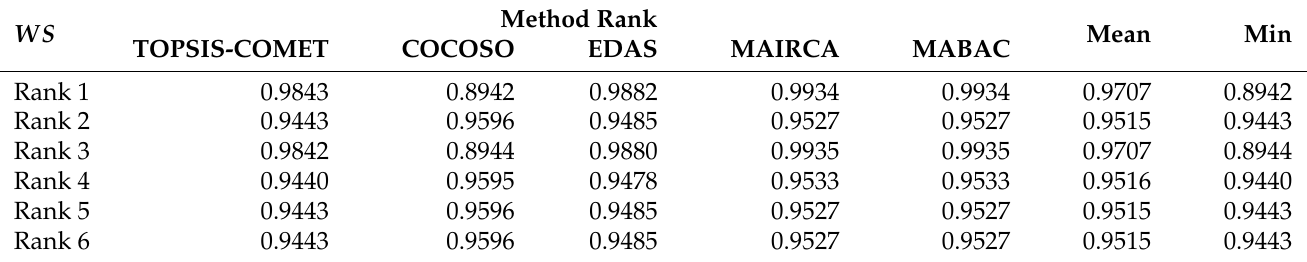
Table 9. Values of similarity coefficient WS for compromise ranking candidates with consideration of sample